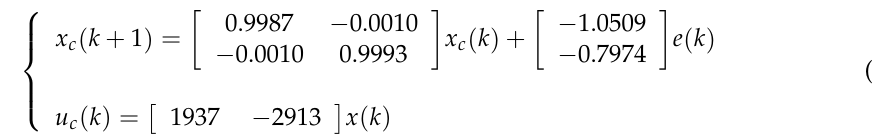
Figure 4. Experimental device.